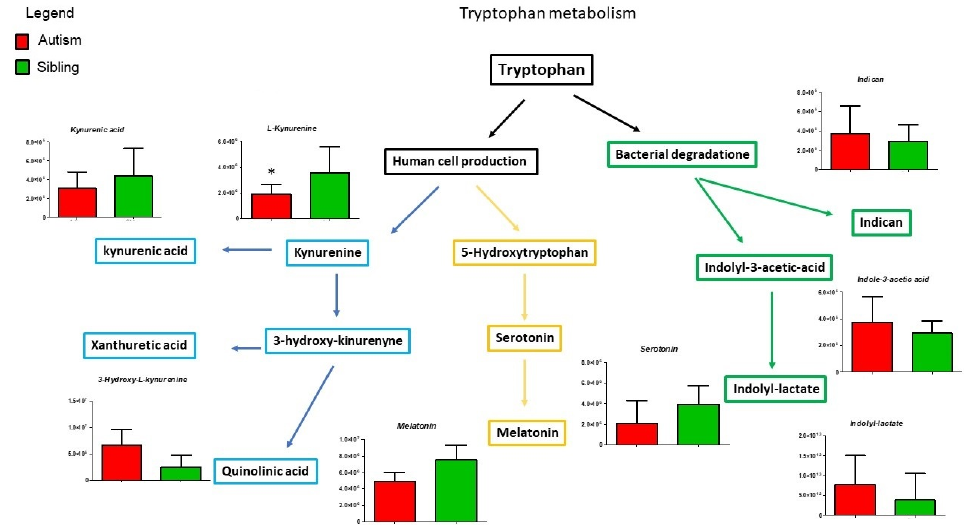
Figure 5. Intermediates of purine metabolism are presented as the differences between autistic subjects in red and typically-developing siblings in green. Inosine, Xanthosine and Hypoxanthine appear to be increased in autistic patients in the urine. The columns represent the mean ± SD (n = 14) of each metabolite concentration. * p < 0.05.